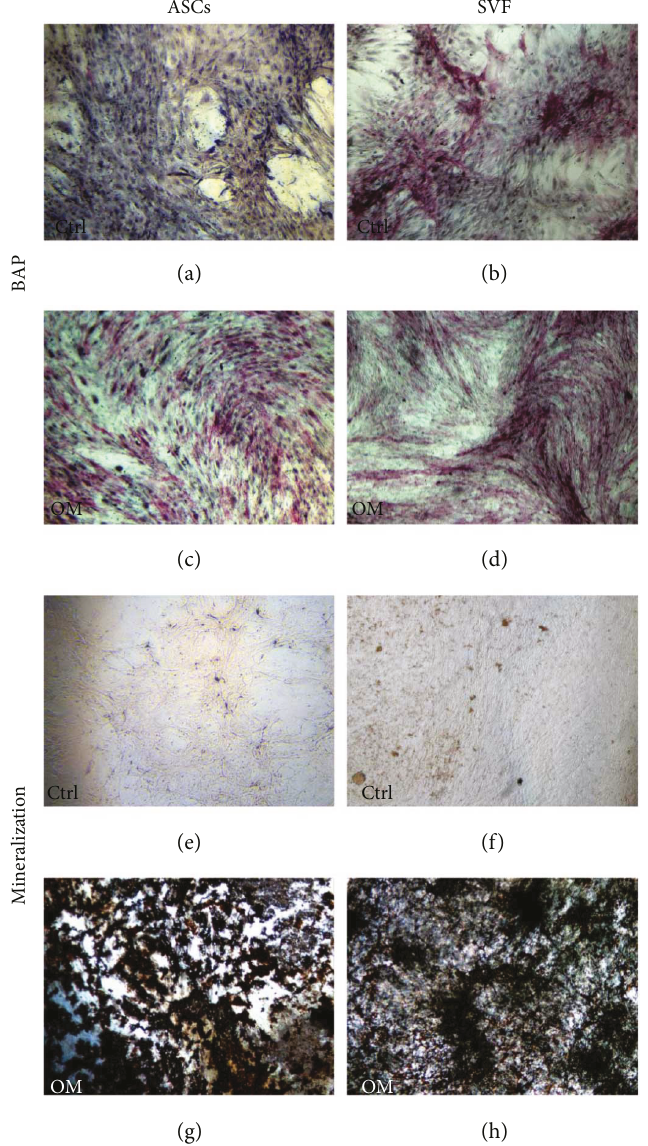
Figure 2: In vitro osteoblastic di ff erentiation of ASCs and SVF. ASCs and SVF were cultured in the absence (ctrl) or in the presence of osteogenic medium (OM), for 60 days. In ctrl cultures, ALP expression is negative in ASCs (a), whereas it is positive in SVF (b). In the presence of OM, both ASCs and SVF show ALP-positive cells (c, d). For both ASCs and SVF, von Kossa staining is negative in the ctrl (e, f) and show mineral nodules with OM (g, h). Magni fi cation